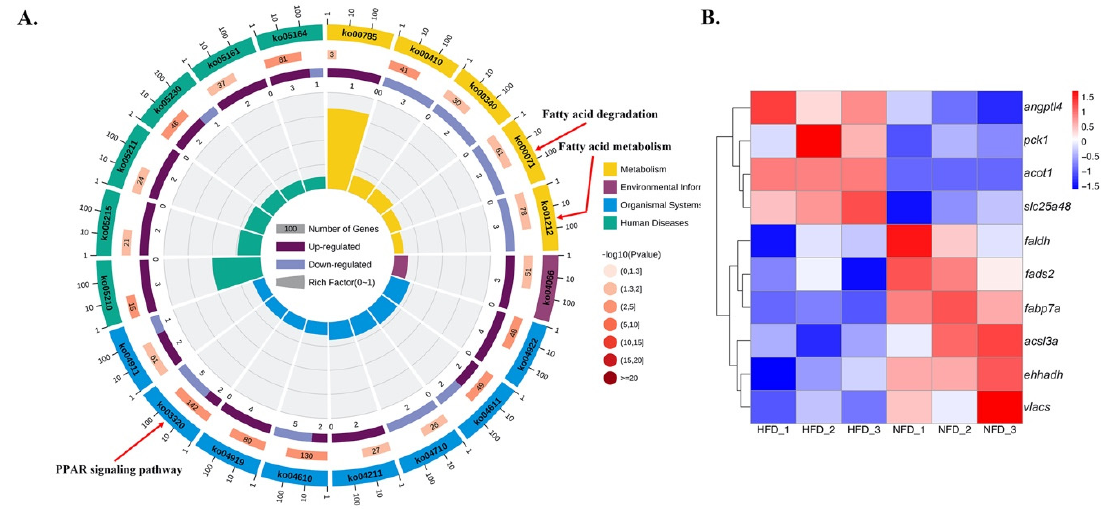
Figure 5. ( A ) Results of KEGG enrichment analysis showing lipid metabolism-related pathways enriched with genes that are potentially trans -regulated by lncRNAs. ( B ) Heatmaps and hierarchical clustering of 10 selected mRNAs. Red, high expression; blue, low expression.